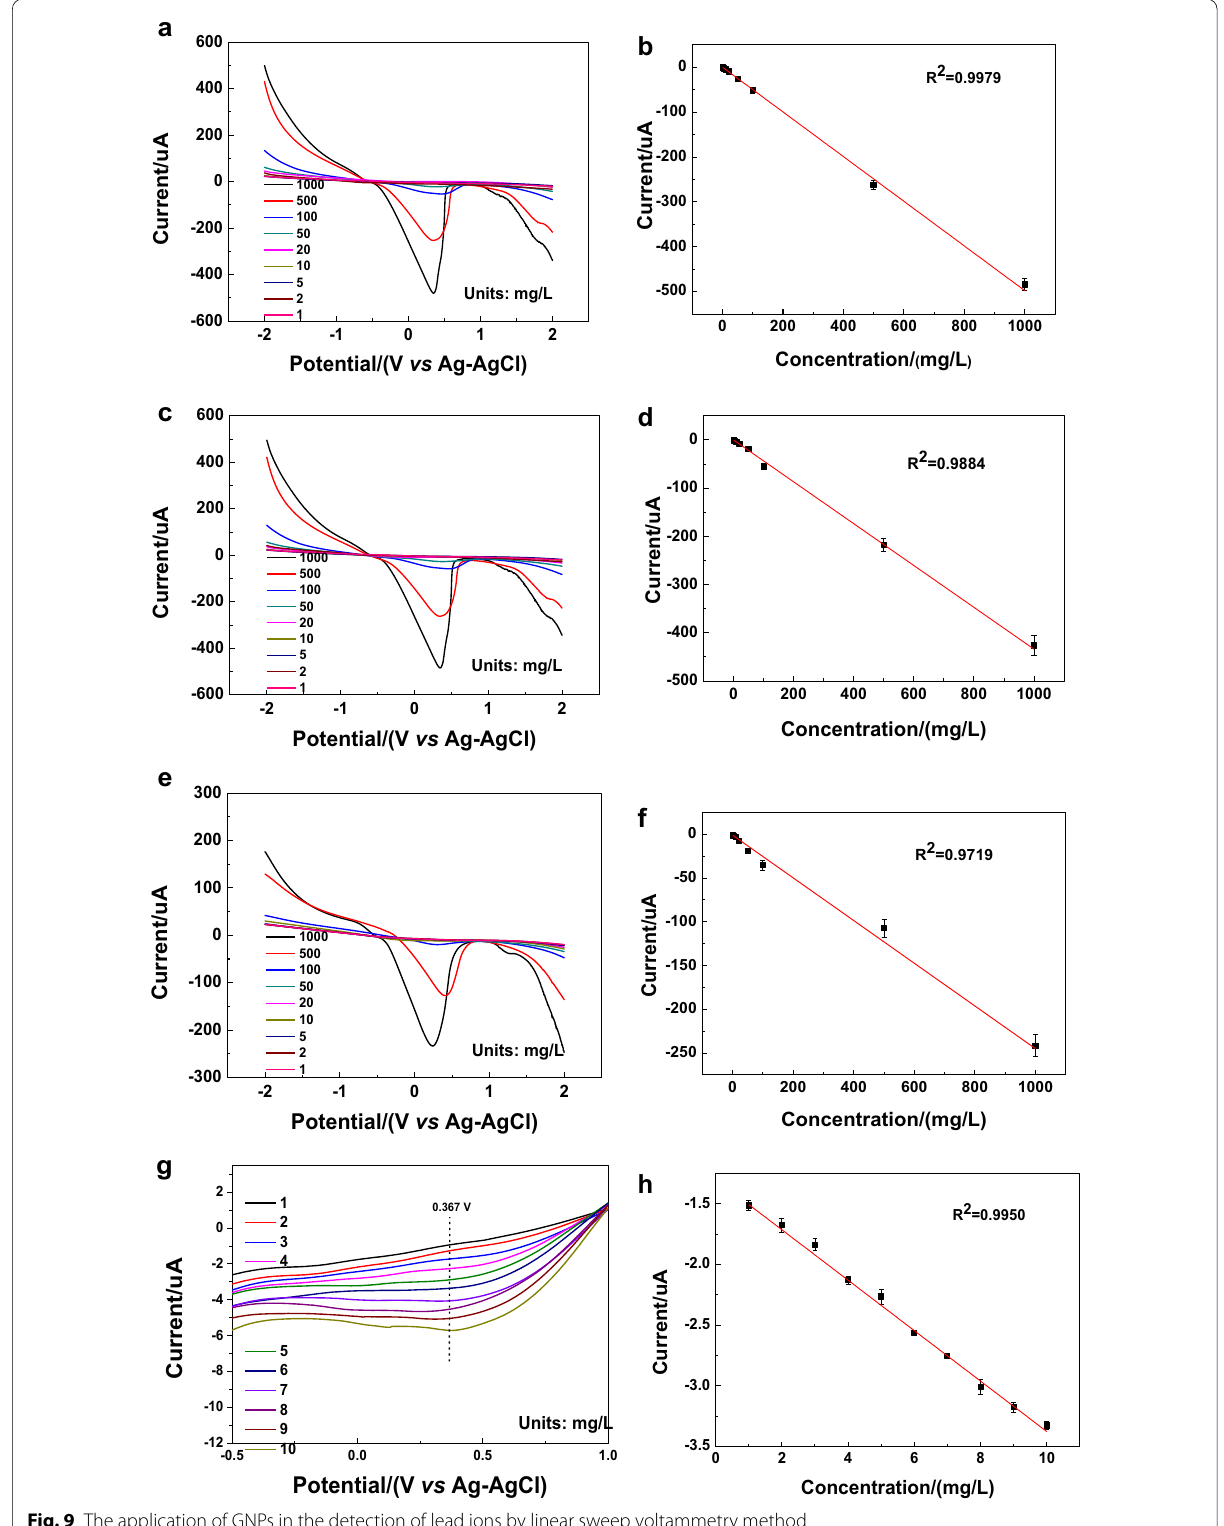
Fig. 9 The application of GNPs in the detection of lead ions by linear sweep voltammetry